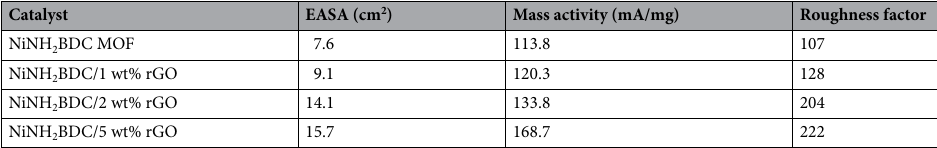
Table 4. EASA, Mass activity, and Roughness factor comparison of NiNH 2 BDC MOF/1, 2, 5 wt% reduced graphitic carbon hybrids.